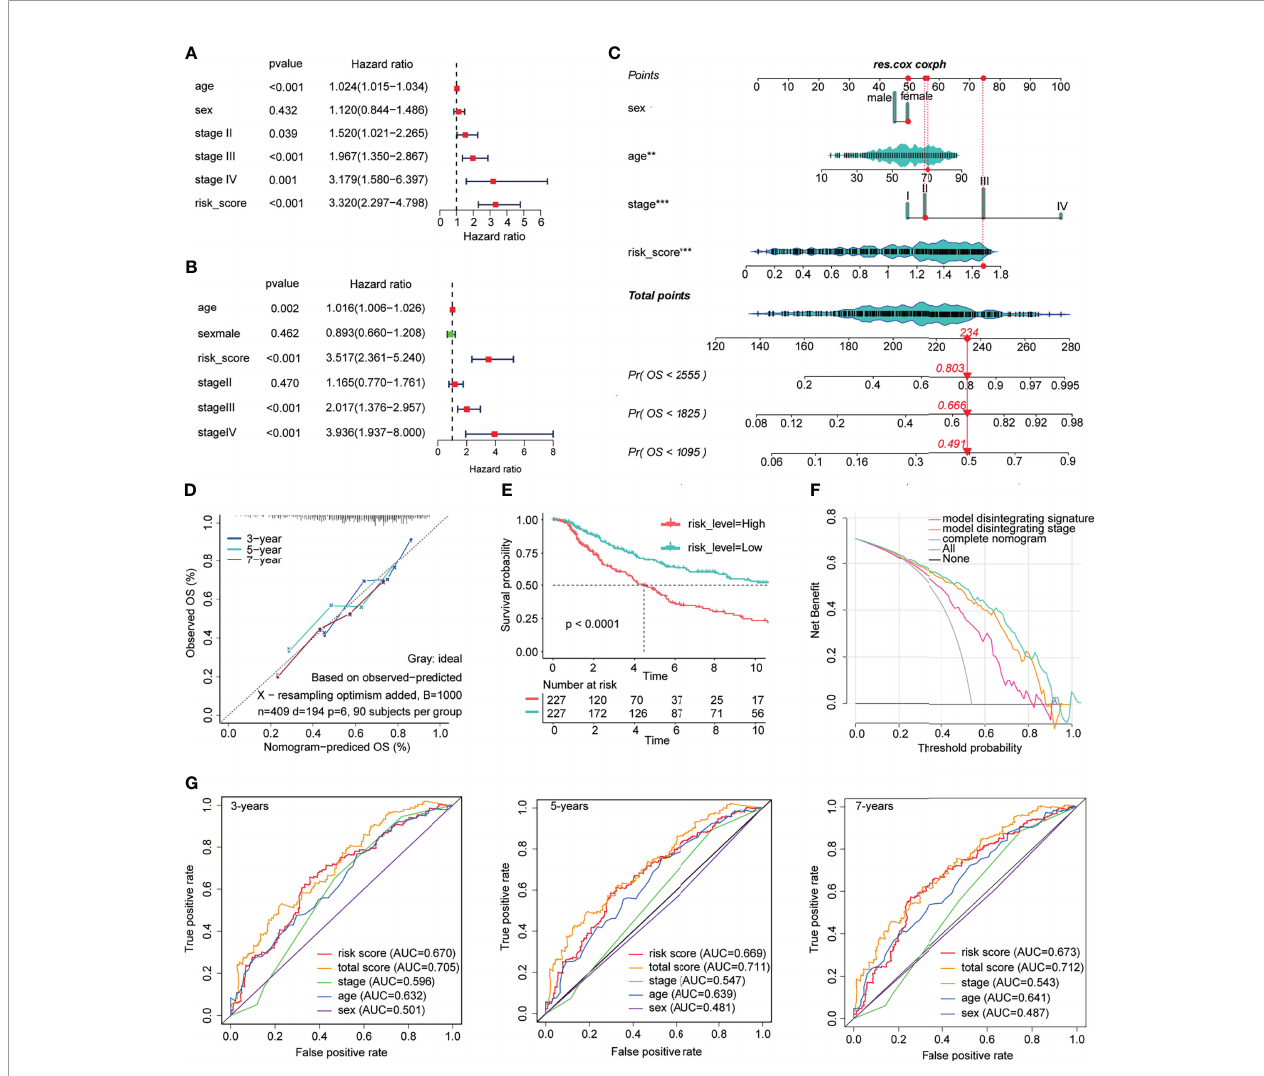
FIGURE 7 | Construction and validation of prognostic nomograph. The univariate and multivariate Cox regression model (A, B) . The nomogram model was built by using the coef fi cients of the multivariate Cox regression model (C) . According to the calibration curve, predictive values were consistent with observed values considering the probabilities of 3-year, 5-year, and 7-year OS (D) . The AUC values for 3-, 5-, and 7-year survival using the predictive nomogram reached 0.705, 0.711, and 0.702, respectively (G) . Kaplan – Meier analysis showed that patients with a high-risk score had an obviously worse OS than patients with a low-risk score (E) . Finally, clinical decision analysis (DCA) shows that the clinical bene fi t rate of the model without stage alone is higher than that of the model without ICBPS alone (F)